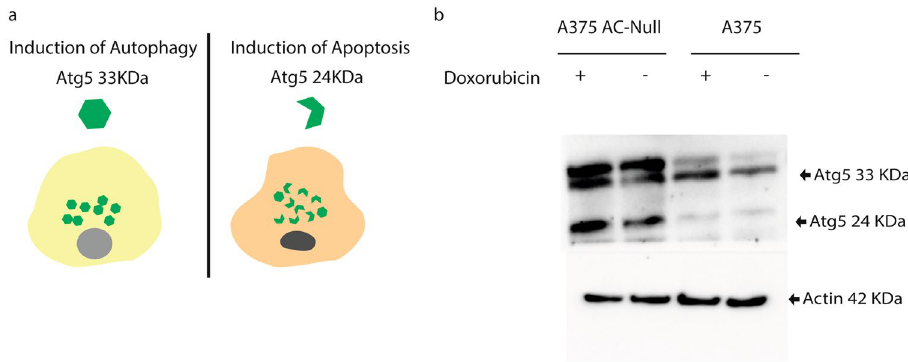
Figure 7. A375 AC-null cells scored positive for the pro-apoptotic Atg5 cleaved protein. ( a ) Schematic illustration of the role of Atg5 in the regulation of autophagy and apoptosis. ( b ) Western blot was performed on A375 WT and A375 AC-null cells treated with 500 nM of doxorubicin for 24 h. Western blot analysis show the presence of the pro-apoptotic cleaved Atg5 protein in the A375 AC-null cells lysate while it is not detected in the A375 WT cells. Uncropped western blots are shown in Supplementary